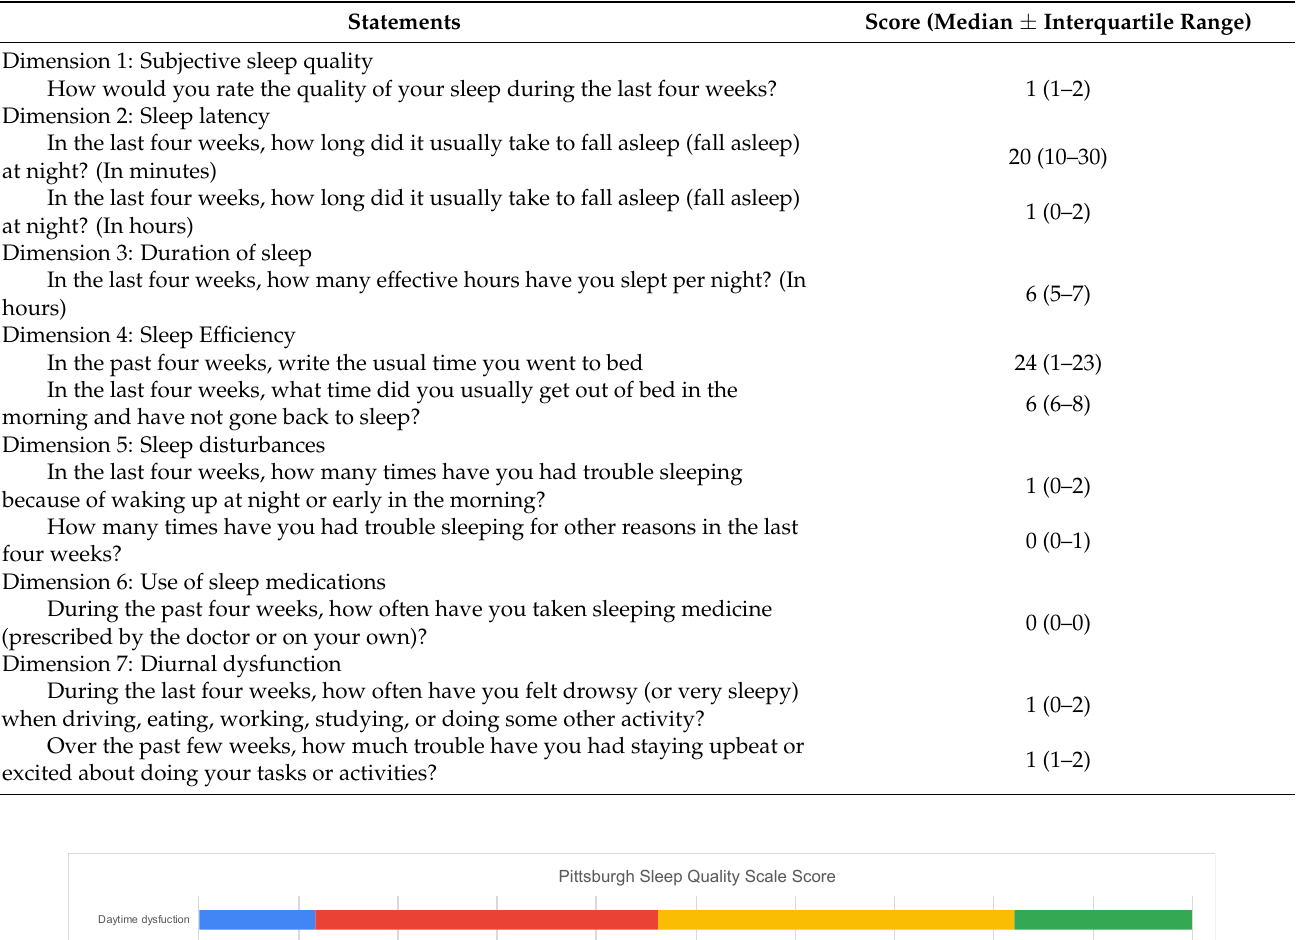
Table 2. Score on each PSQI item ( n = 3139).